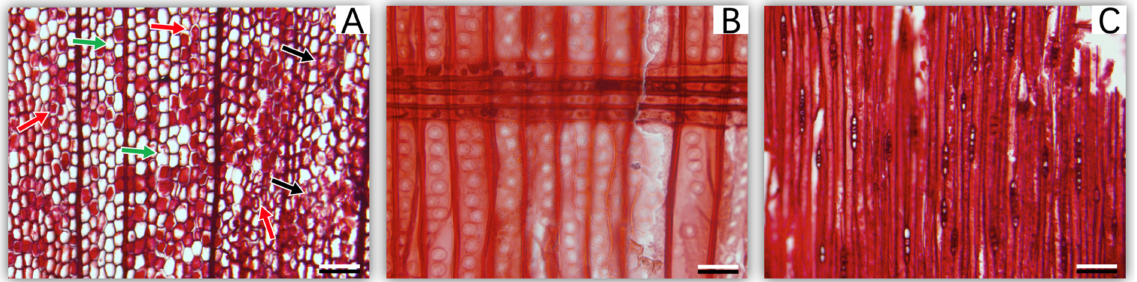
Figure 1. Morphological structure of waterlogged archaeological fir wood. ( A ) Transverse section (arrows display obvious decay patterns indicating decayed fibre cell walls); ( B ) radial section; and ( C ) tangential section. Scale bar = 50 µ m.